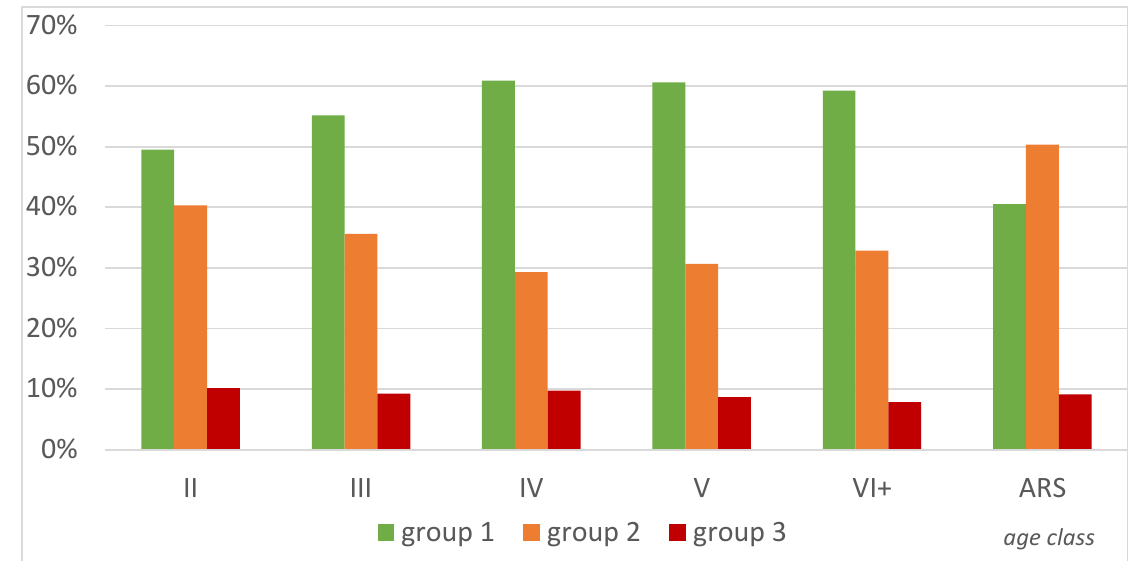
Figure 3. Need and urgency of intervention in stands of different age classes.